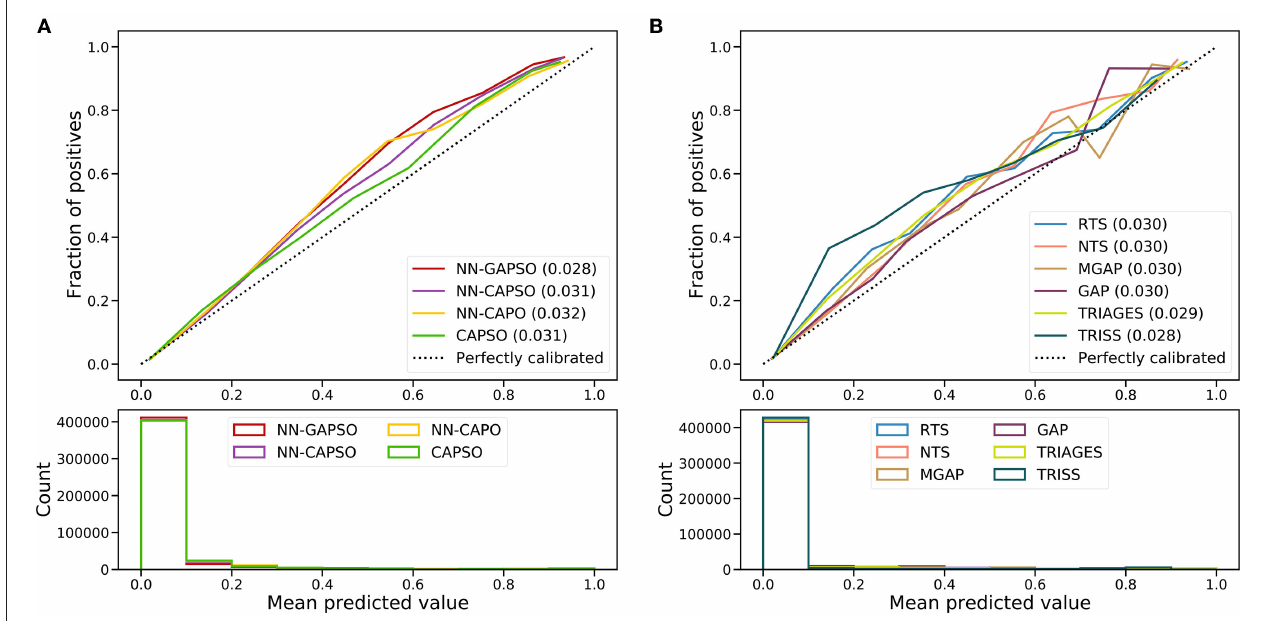
FIGURE 3 | Calibration curves of newly developed models (A) and trauma scores (B) in the validation cohort. NN , Neural network; GAPSO , Glasgow Coma Scale, Age, Pulse Rate, Systolic Blood Pressure, and Peripheral Oxygen saturation; CAPSO , the Ability to Follow Commands, Age, Pulse Rate, Systolic Blood Pressure, and Peripheral Oxygen saturation; CAPO , the Ability to Follow Commands, Age, Pulse Rate, and Peripheral Oxygen saturation; RTS , Revised Trauma Score; NTS , New Trauma Score; MGAP , Mechanism, Glasgow Coma Scale, Age, and Arterial Pressure; GAP , Glasgow Coma Scale, Age, and Systolic Blood Pressure Score; TRIAGES , Trauma Rating Index in Age, Glasgow Coma Scale, Respiratory rate and Systolic blood pressure; TRISS , Trauma and Injury Severity Score.